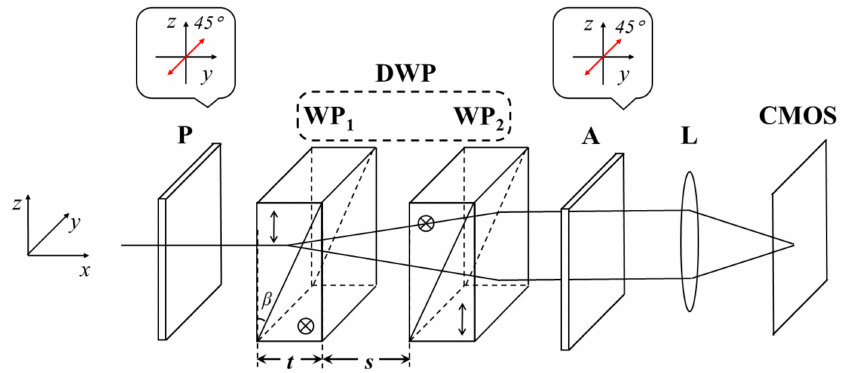
Figure 1. The schematic of the SBFTIS.